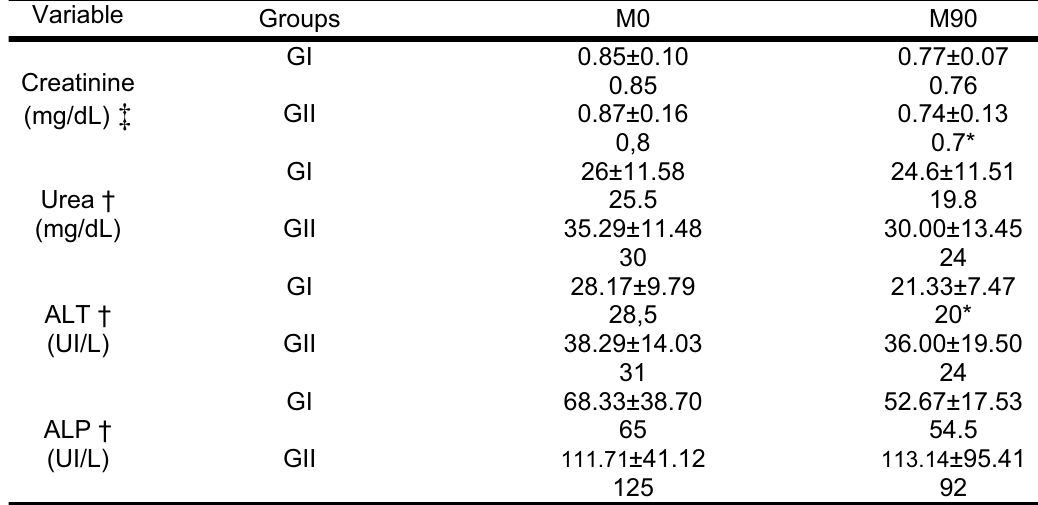
TABLE 3 - Distribution of means ±standard deviations and medians, according to the group (GI – control and GII – SAF) for biochemistry variables (creatinine, urea, ALT and ALP) in bitches submitted to general inhalatory